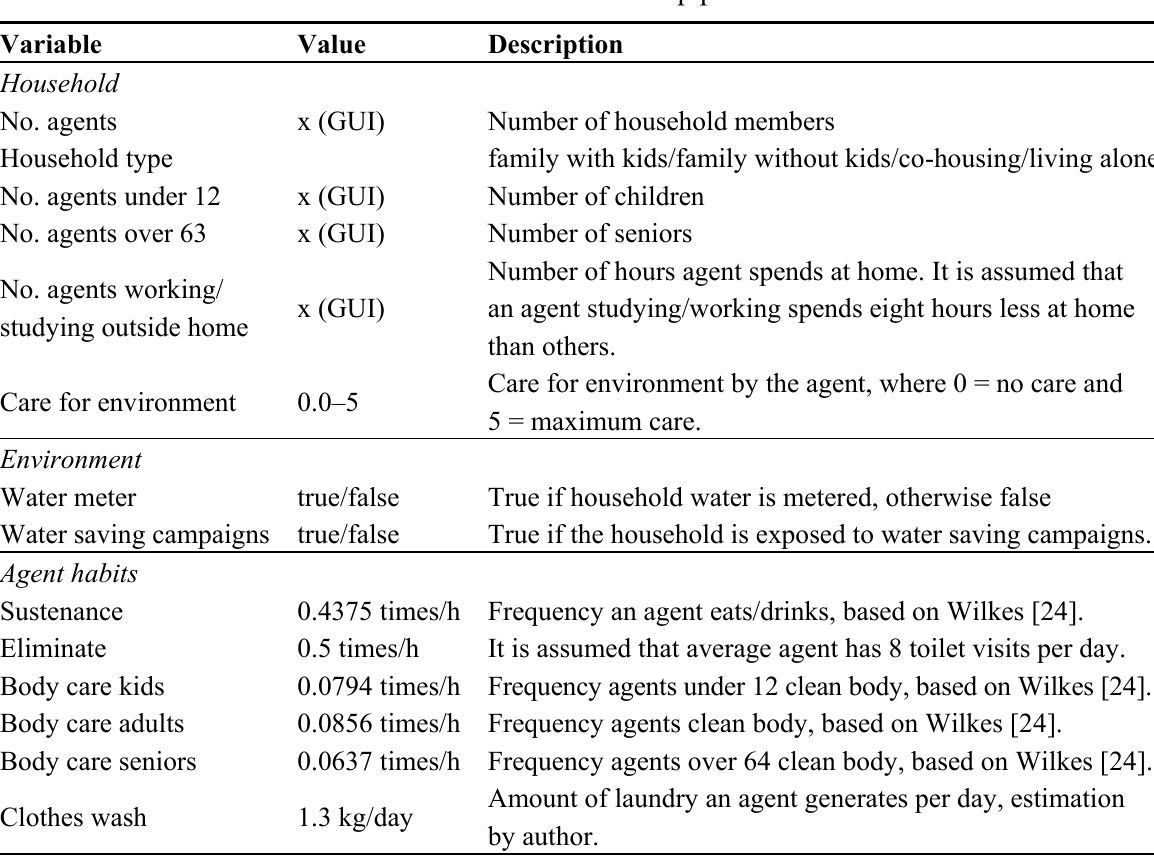
Table 2. A list of model set-up